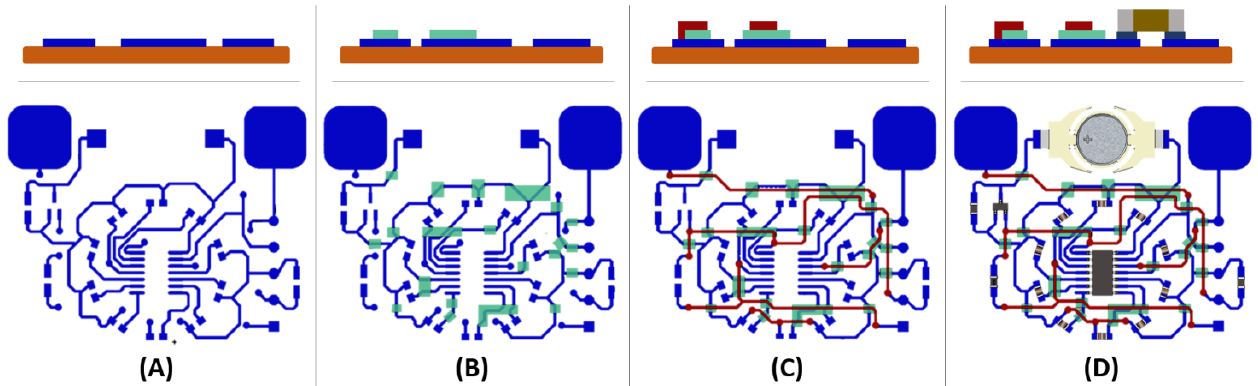
Figure 3. Schematic side views ( top ) and schema top views ( bottom ) of the multilayer demonstrator in the following fabrication steps: ( A ) Printing of the first conductive layer (in blue) with three printing cycles followed by annealing during 4 h at 100 °C. (The substrate is illustrated in orange in the side views). ( B ) Printing of the UV insulating layer (in green) with three printing cycles followed by a waiting time of 15 min, then exposure to UV radiation for 1 min. ( C ) Printing of the second conductive layer (in red) with three printing cycles followed by annealing during 4 h at 100 °C. ( D ) Mounting of electronic components where each electronic component has been fixed on its footprint by means of a conductive ink dispenser. This step is followed by annealing for 4 h at 100 °C.